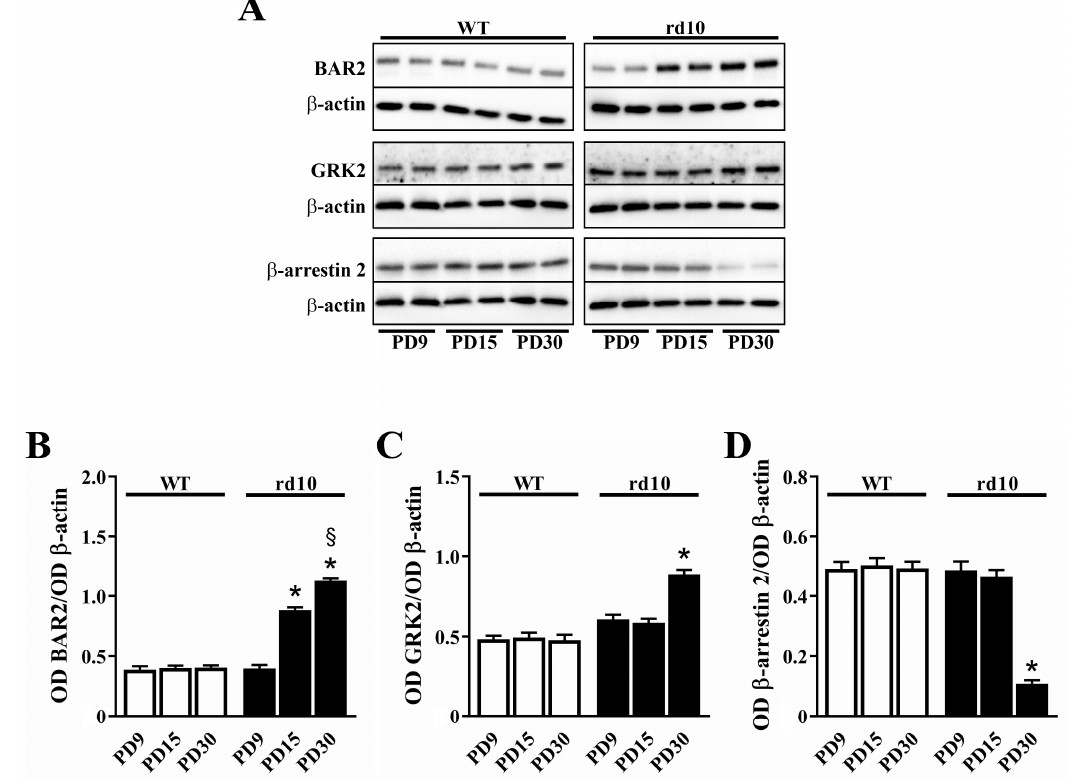
Figure 3. Developmental expression of BAR2, G protein-coupled receptor kinase (GRK)2 and β -arrestin 2 in the retina of WT and rd10 mice. ( A ) Representative Western blots from retinal homogenates. ( B – D ) Densitometric analysis of BAR2 ( B ), GRK2 ( C ) and β -arrestin 2 ( D ) levels. In WT mice, no differences in the levels of BAR2, β -arrestin 2 or GRK2 were observed from PD9 to PD30. In rd10 mice, BAR2 progressively increased. At PD30, GRK2 levels were drastically higher than at PD9, while β -arrestin 2 levels were drastically lower ( n = 5 samples per group, each containing 2 retinas from independent mice). * p < 0.001 versus rd10 at PD9; § p < 0.001 versus rd10 at PD15 (one-way ANOVA followed by the Tukey post-hoc test).